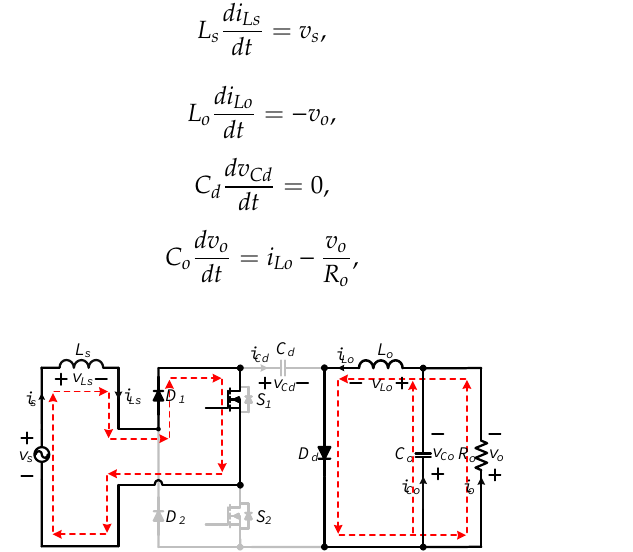
Figure 6. Equivalent circuit of the bridgeless Cuk converter in State 2 during positive half line cycle.